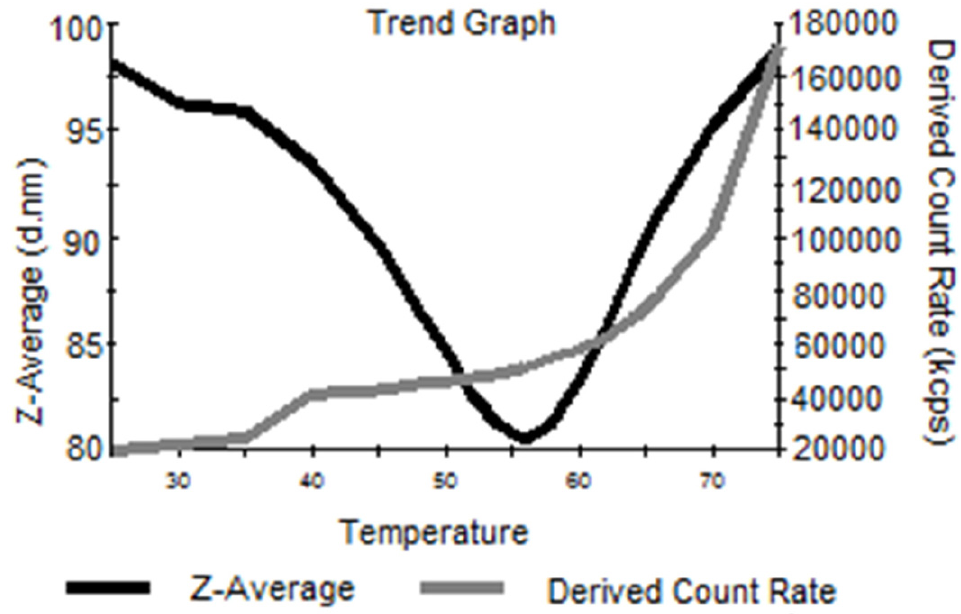
Figure 5. Apparent hydrodynamic average diameters as a function of temperature for a 3 mg mL -1 solution of PSI (A6) as obtained from the DLS